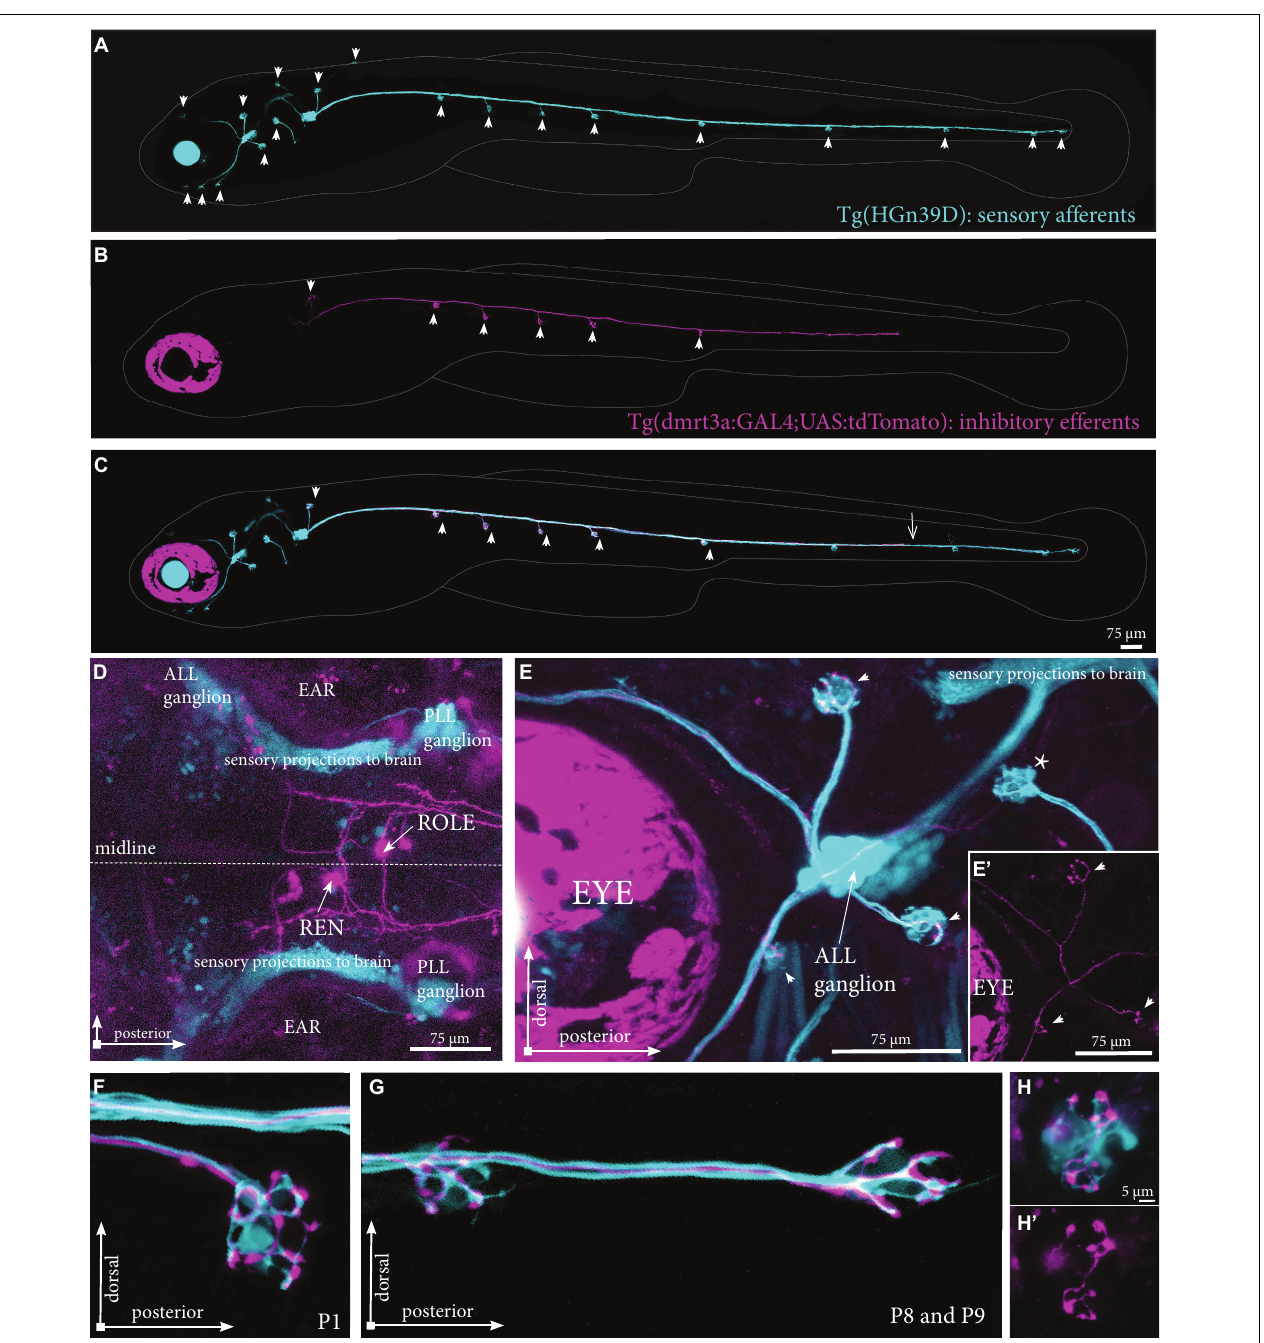
FIGURE 3 | Projections by single inhibitory efferent cells. (A) Overview of the sensory afferent projections in Tg(HGn39D) at 5 dpf. Arrowheads indicate sites of neuromast innervation. (B) A single labeled inhibitory efferent neuron in Tg( dmrt3a :GAL4;UAS:tdTomato) showing partial coverage of the lateral line by its projections. Arrowheads indicate sites of neuromast innervation. (C) Overlay of A and B. Arrowheads indicate sites of afferent and efferent innervation of neuromasts. Arrow indicates the growth cone of the inhibitory efferent projection. Note that A-C do not show the original confocal image, but a modified version to show the lateral line projections only; for the original images, please see Supplementary Figure 2 . (D) Top view of a Tg( dmrt3a :GAL4;UAS:tdTomato), where only a single cell in the REN and a single cell in the CEN (ROLE) can be seen. (E) Zoomed image of the ALL ganglion of Tg(HGn39D; dmrt3a :GAL4;UAS:tdTomato) reveal a single projection along the lateral line nerve of the ALL. Arrowheads indicate sites of neuromast innervation by the inhibitory efferent. Asterisks indicate neuromasts without inhibitory efferent innervation [ (E’) shows the inhibitory efferent projection only]. (F–G) Higher magnification of Tg(HGn39D; dmrt3a :GAL4;UAS:tdTomato), showing the sensory afferents and a single efferent projection innervating a neuromast at P1 (F) and at P8 and P9 (G) . (H) Example of a neuromast that is only partially innervated by the single inhibitory efferent [ (H’) shows the inhibitory efferent projection only]. ALL, anterior lateral line; PLL, posterior lateral line; REN, the rostral efferent nucleus; ROLE, the rhombencephalic octavolateral efferent neuron; RELL, the rhombencephalic efferent neuron to the lateral line.